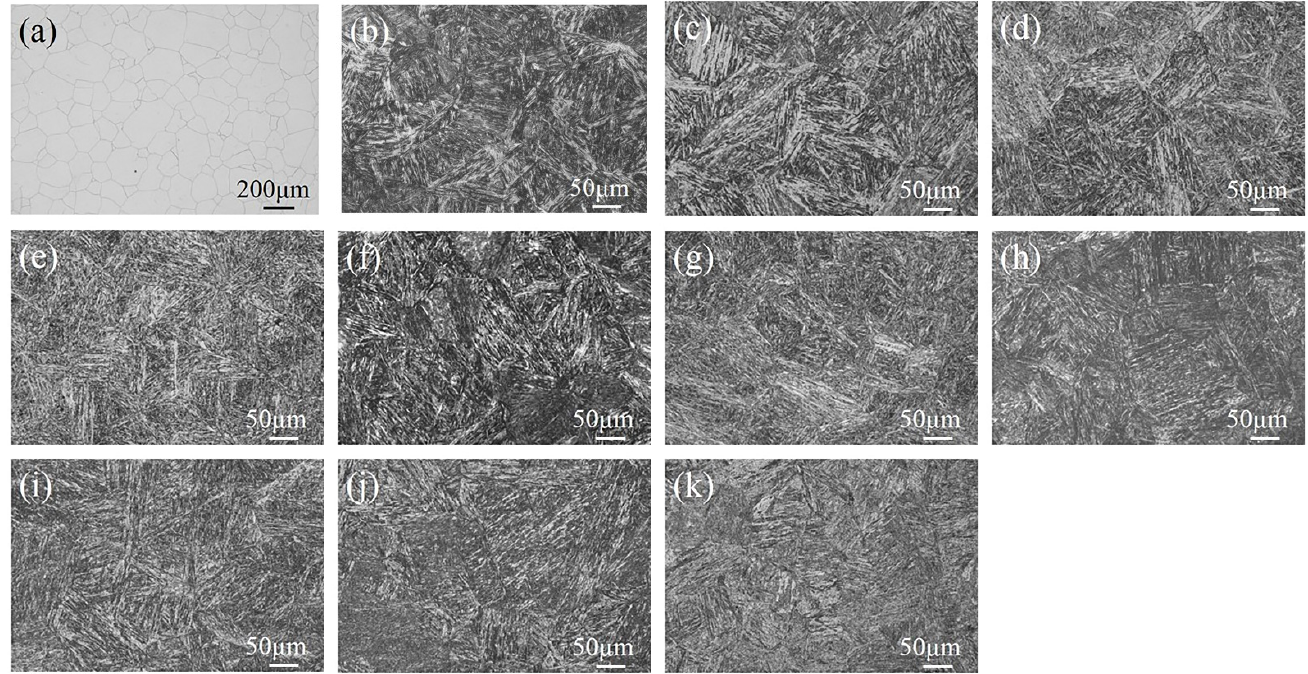
Figure 1. Microstructure of the specimens under various thermal conditions: ( a ) PAGBs, ( b ) DC, ( c ) 480A-0.5, ( d ) 480A-4, ( e ) 480A-80, ( f ) 540A-0.5, ( g ) 540A-4, ( h ) 540A-80, ( i ) 600A-0.5, ( j ) 600A-4, and ( k ) 600A-80.